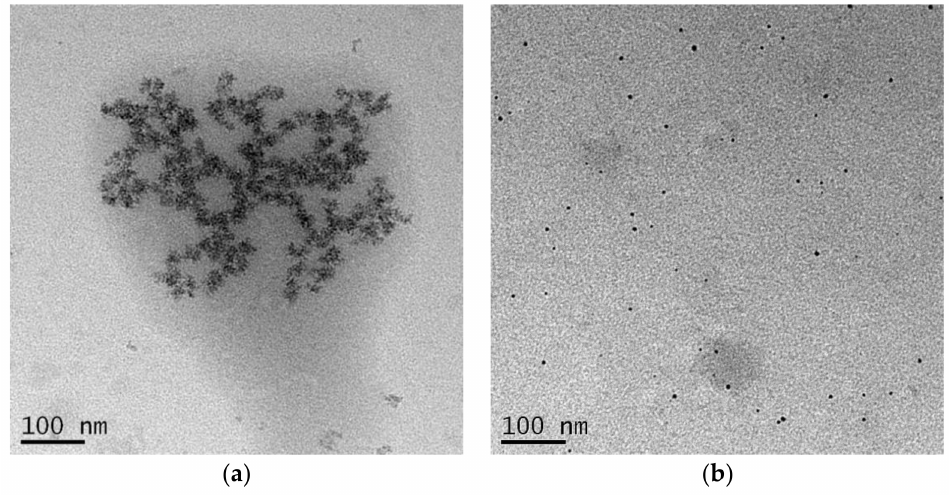
Figure 3. TEM images of ( a ) TSB-Ag and ( b ) Tau-Ag. Micrographs were captured at 25,000 × magnification.